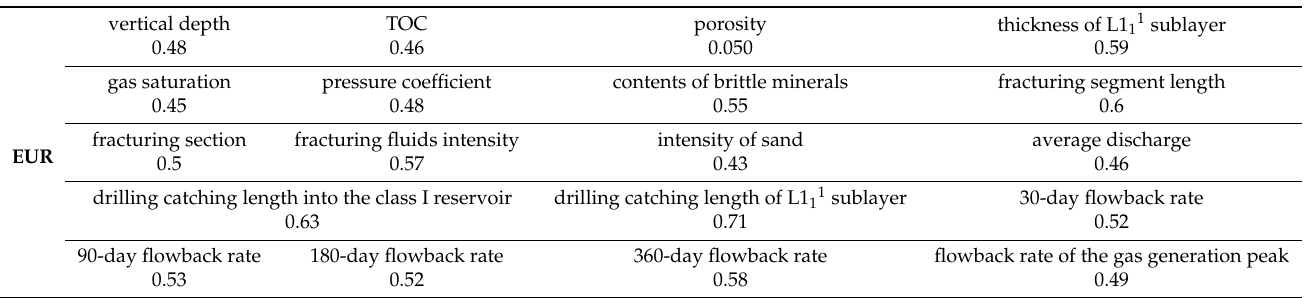
Table 4. Pearson correlation coefficient table.